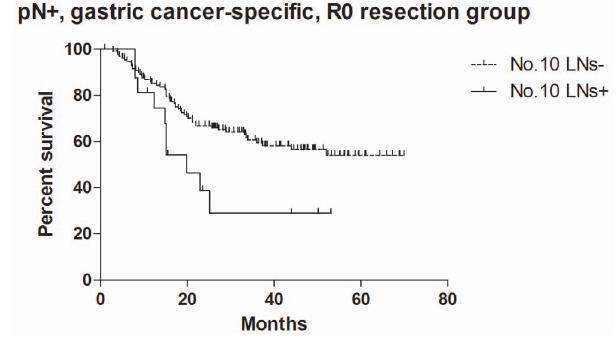
Figure 8. Kaplan-Meier survival analysis of pT4 stage gastric cancer specific + R0 resection group in all patients.